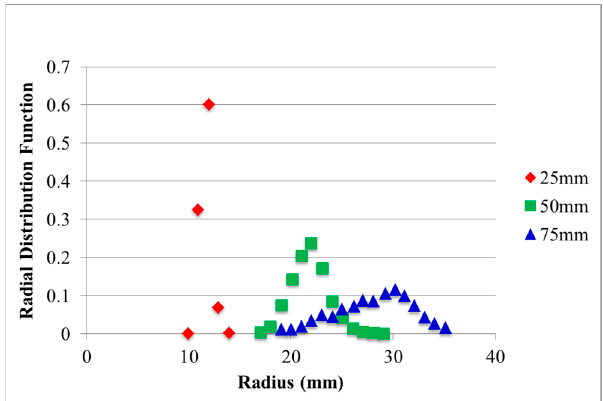
Figure 11. Radial distribution of droplet position at 25, 50, and 75 mm with non-swirling atomizing air.